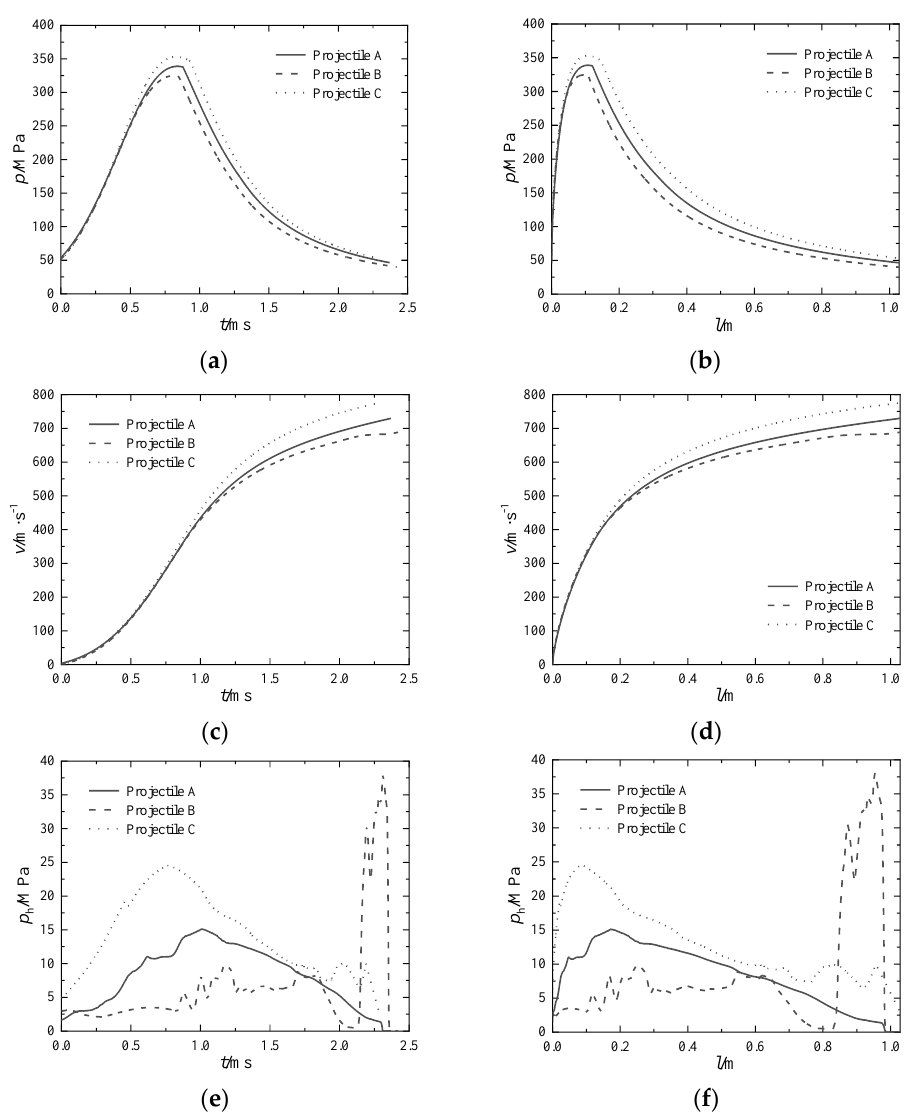
Figure 5. Interior ballistics curves of gas-curtain launcher under three jet structures; ( a ) p-t ; ( b ) p-l ; ( c ) v-t ; ( d ) v-l ; ( e ) p h -t ; ( f ) p h -l .